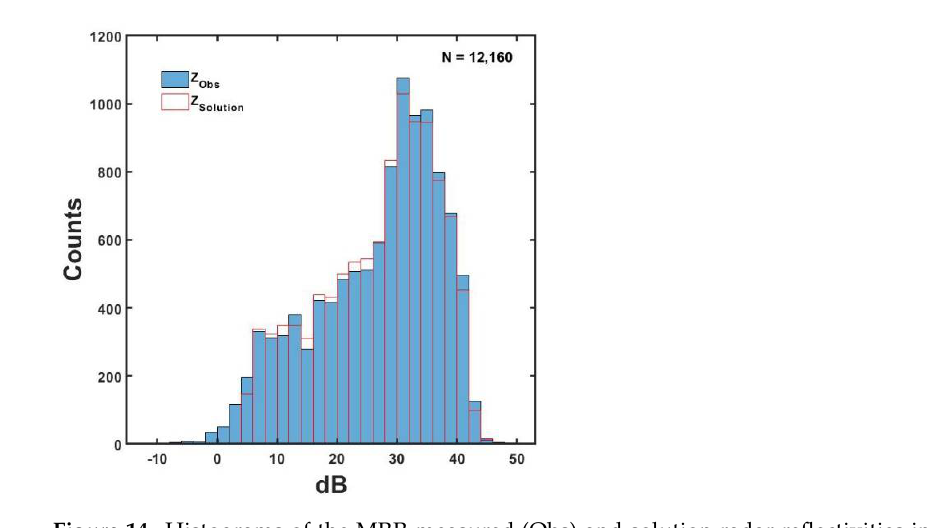
Figure 14. Histograms of the MRR measured (Obs) and solution radar reflectivities in Figure 13 showing the excellent matching suggesting the general validity of the solutions.